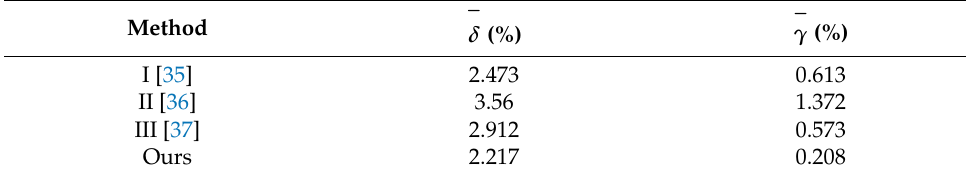
Table 7. Comparison of the accuracy of pointer meters’ reading